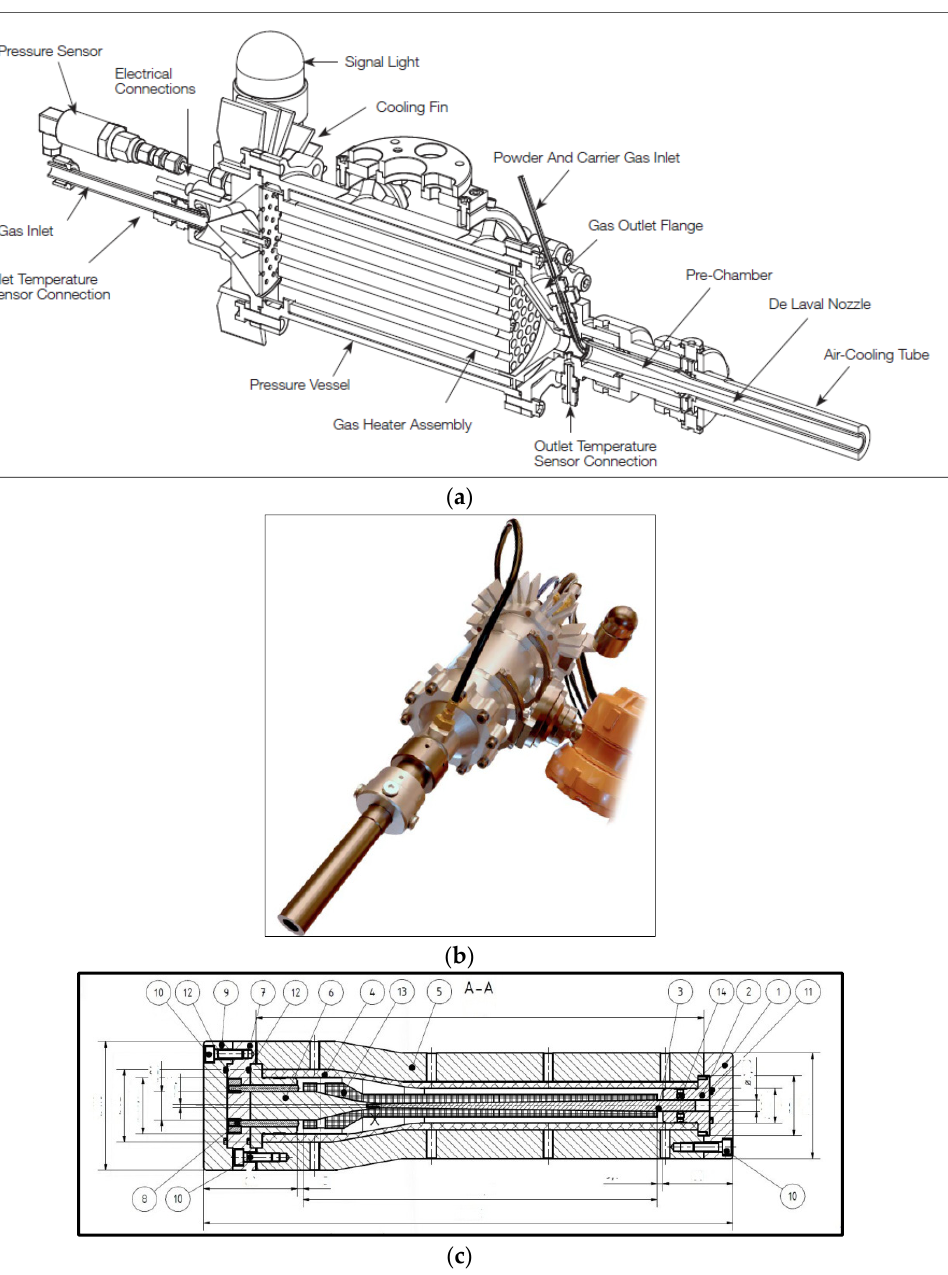
Figure 3. Cold spray gun: ( a ) schematic, ( b ) photograph, ( c ) deLaval nozzle design [ courtesy: Impact Innovations ].